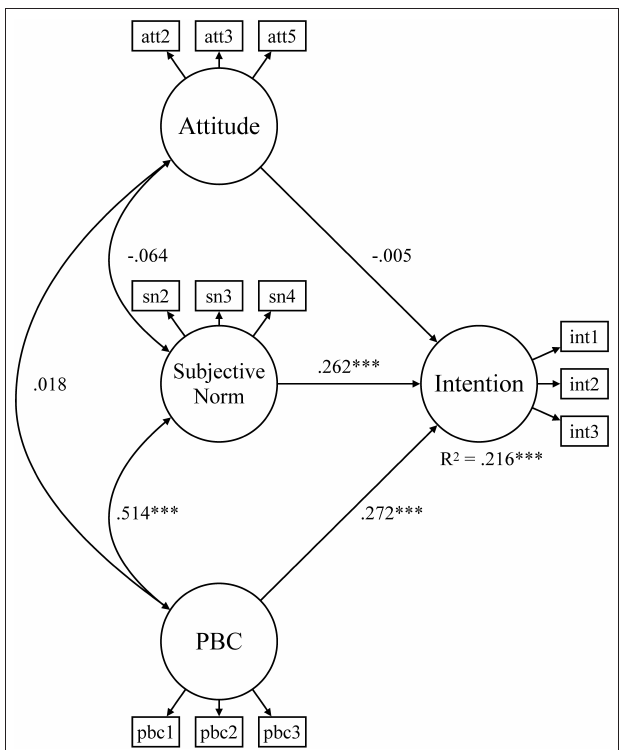
FIGURE 4 | Structural equation model for environmentally friendly behavioral intentions of football club members. PBC, perceived behavioral control ; *** p <